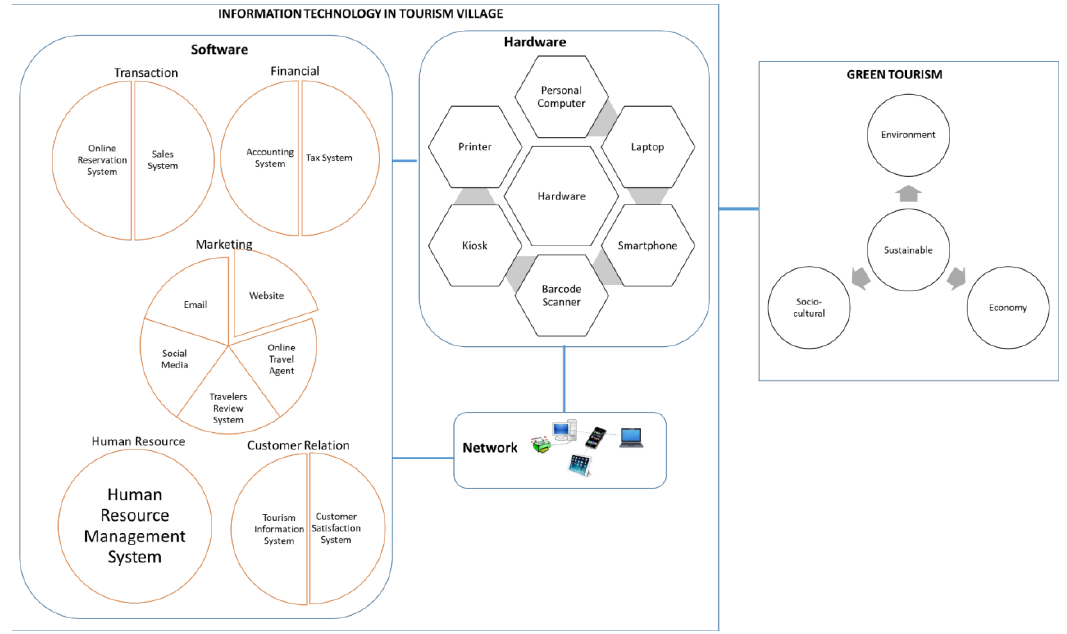
Figure 2. Green Tourism-Based Model of Information Technology Utilization in Tourism